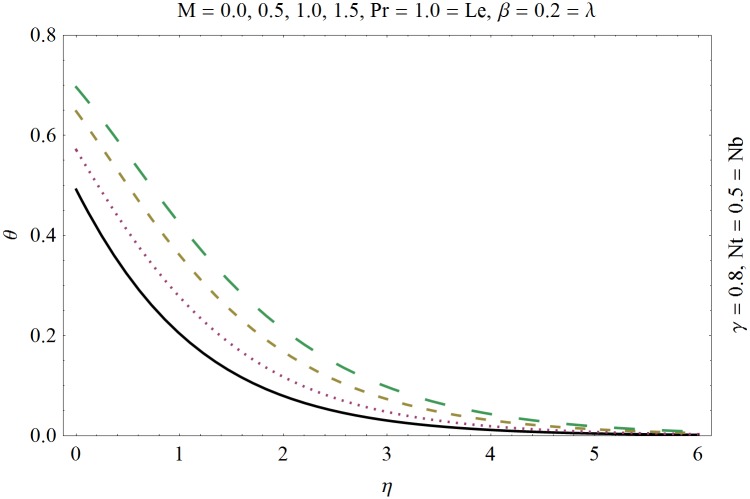
Influence of magnetic field M on θ.